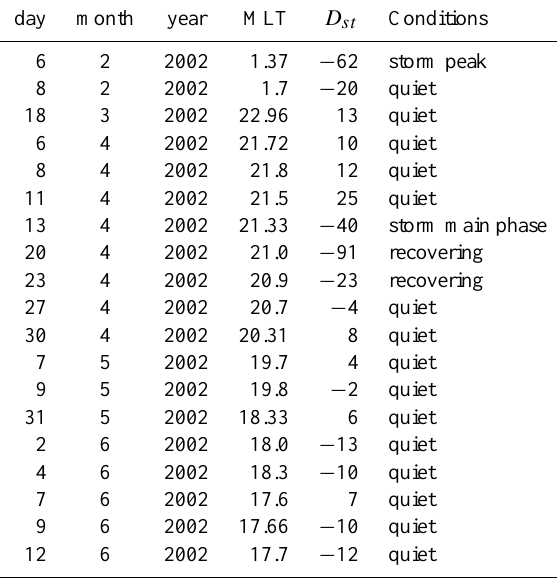
Table 1. Cluster perigee passes (year 2002) used in the statistical study. For each pass is indicated the day, month, year, MLT sector crossed by Cluster at perigee, D st index and the magnetic activity conditions.